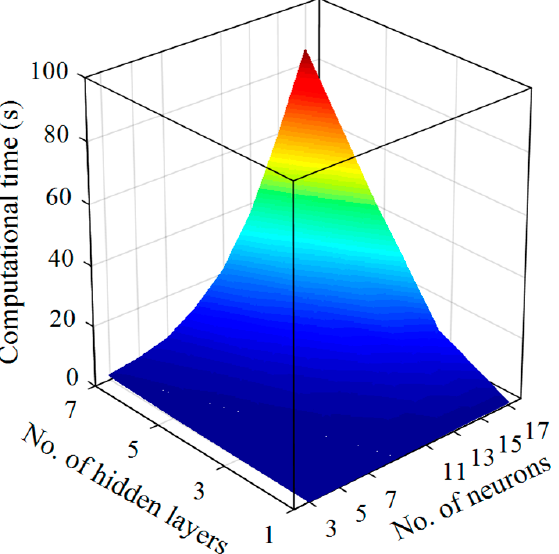
Figure 7. The changes in training time with respect to the changes in the hidden layer number and neuron number.